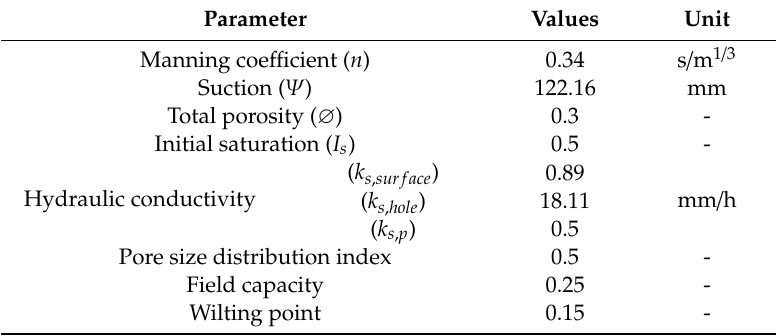
Table 3. Parameters used in the long-term analysis [51,64].